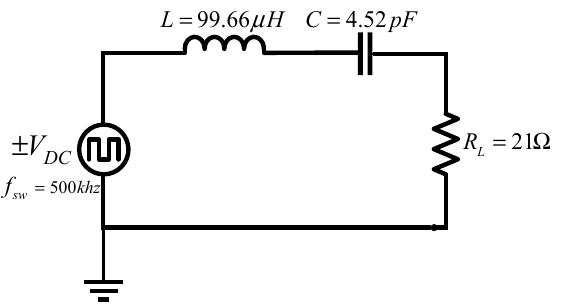
Figure 8. Series RLC circuit designed in the transient state simulated in OrCAD PSpice. The simulation time was 400 µ s, which ensures the stability of the circuit operation.